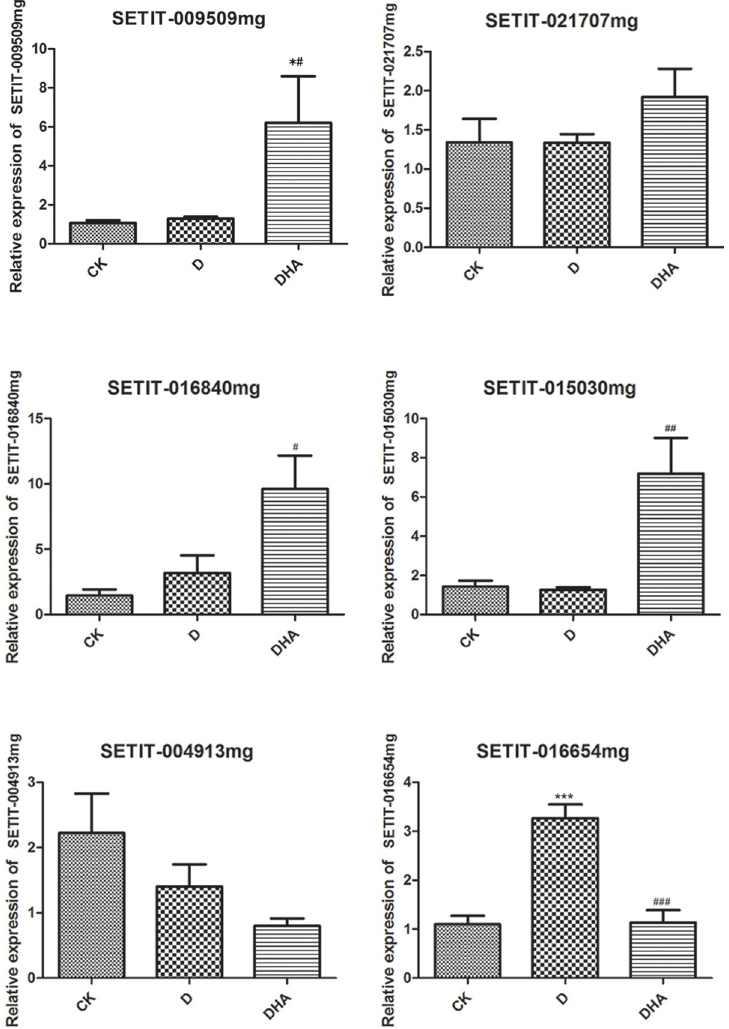
Fig 6. RT-qPCR analysis of gene expression in different HA treatment groups. X-axis represents different groups; y-axis represents relative gene expression. � , p < 0.05 when compared with the CK group; #, p < 0.05 when compared with the D